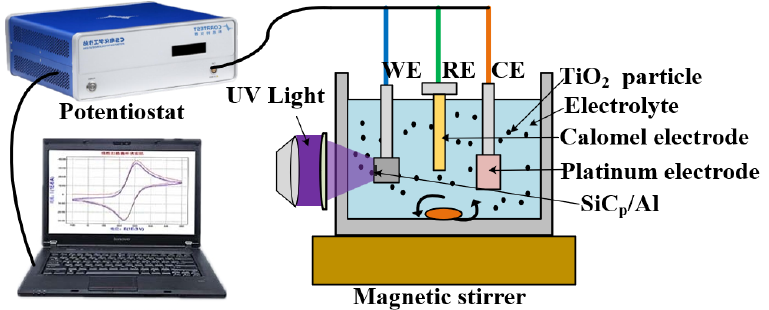
Figure 4. Schematic diagram of the electrochemical measurement device .